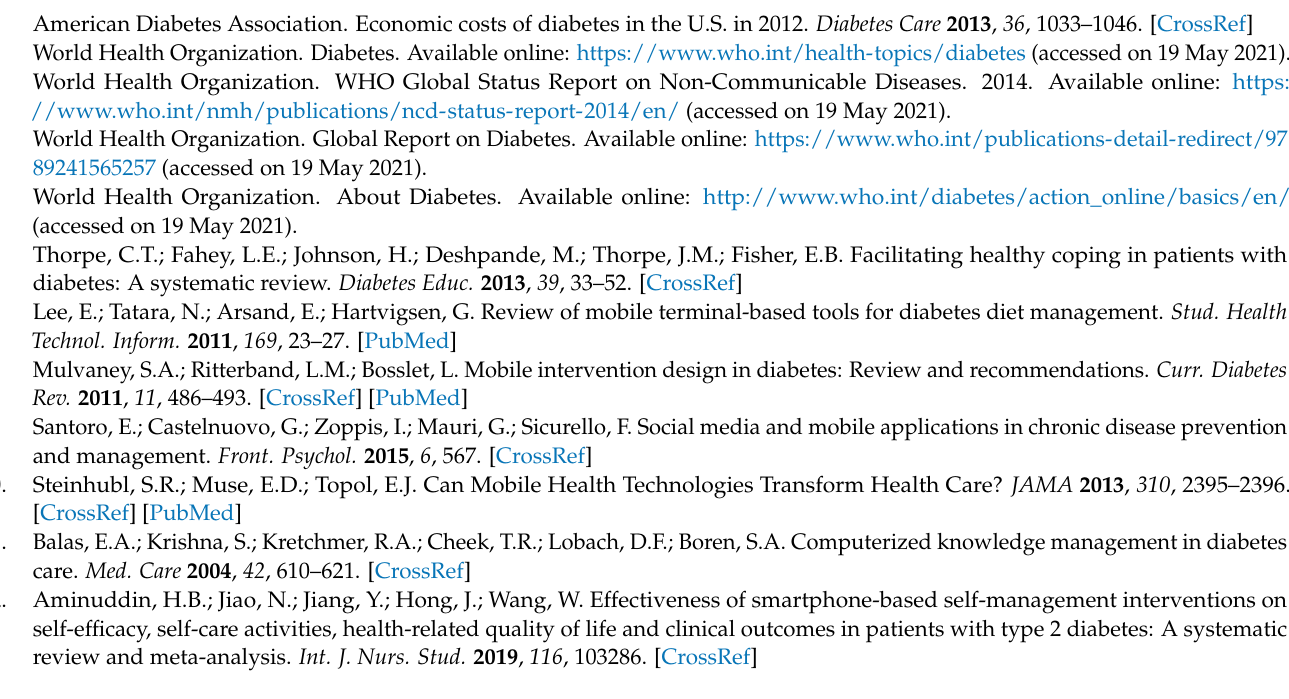
reasons, Figure S2: Risk of Bias Plot, Figure S3: Quality of Life at the endpoint, Figure S4: Diabetes Distress at the